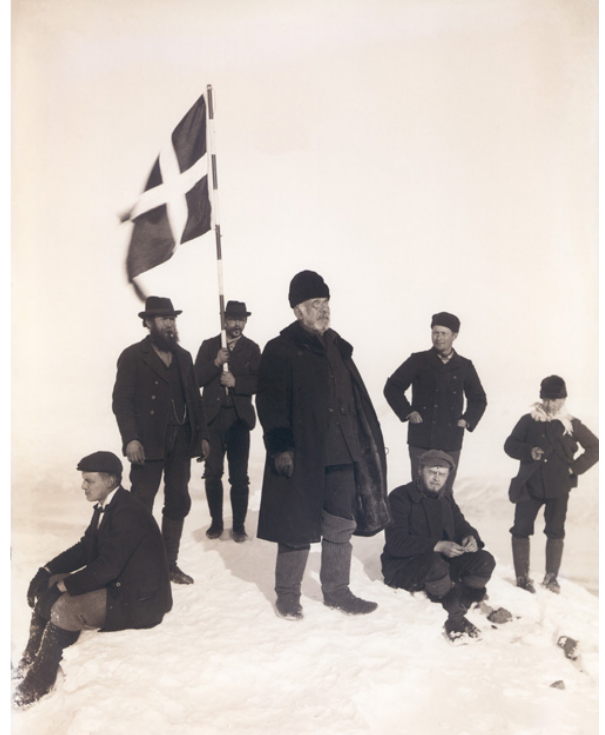
Figure 16. Iceland Expedition team at the top of Sulur mountain (Photo, DMI).